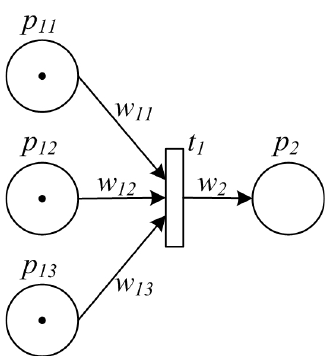
Figure 4. PPN model of synchronization pattern.